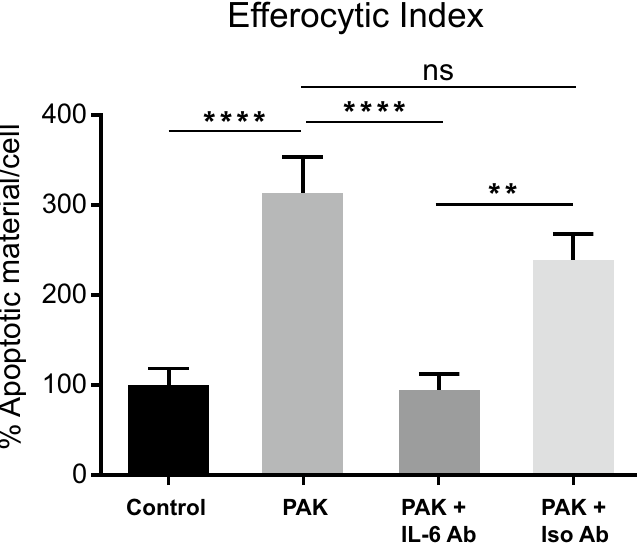
Figure 6. IL-6 mediates the increase of the Efferocytic Index in bacterial pre-stimulated BMDM. BMDM were incubated for 50 min with PAK (bacteria) as pre-stimulus or left unstimulated (Control). The efferocytic capacities using apoptotic cells as targets were checked 18 h after pre-stimuli. Additionally, PAK pre-treatment was evaluated in the constant presence of anti-IL-6-neutralizing monoclonal antibody (IL-6 Ab) or its matching isotype Control (Iso Ab). Efferocytic capacity was determined by confocal microscopy as detailed in Methods. Data were normalized to the Control (non-stimulus: 100%) and expressed as mean ± SEM of three independent experiments, **p = 0.0019 and ****p < 0.0001 vs. Control by one-way ANOVA, followed by Tukey’s multiple comparison